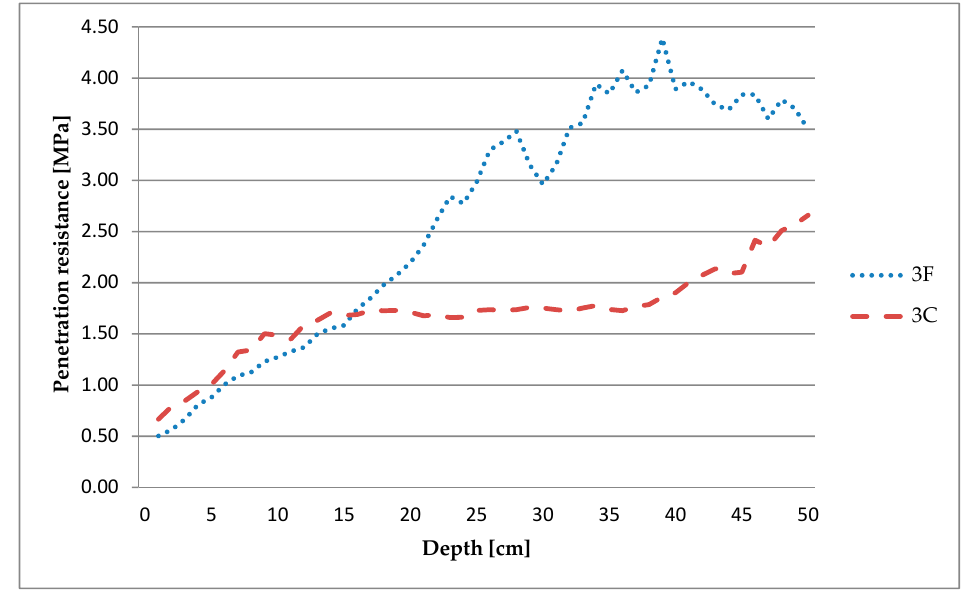
Figure 4. Soil compaction at sites 2F and 2C.